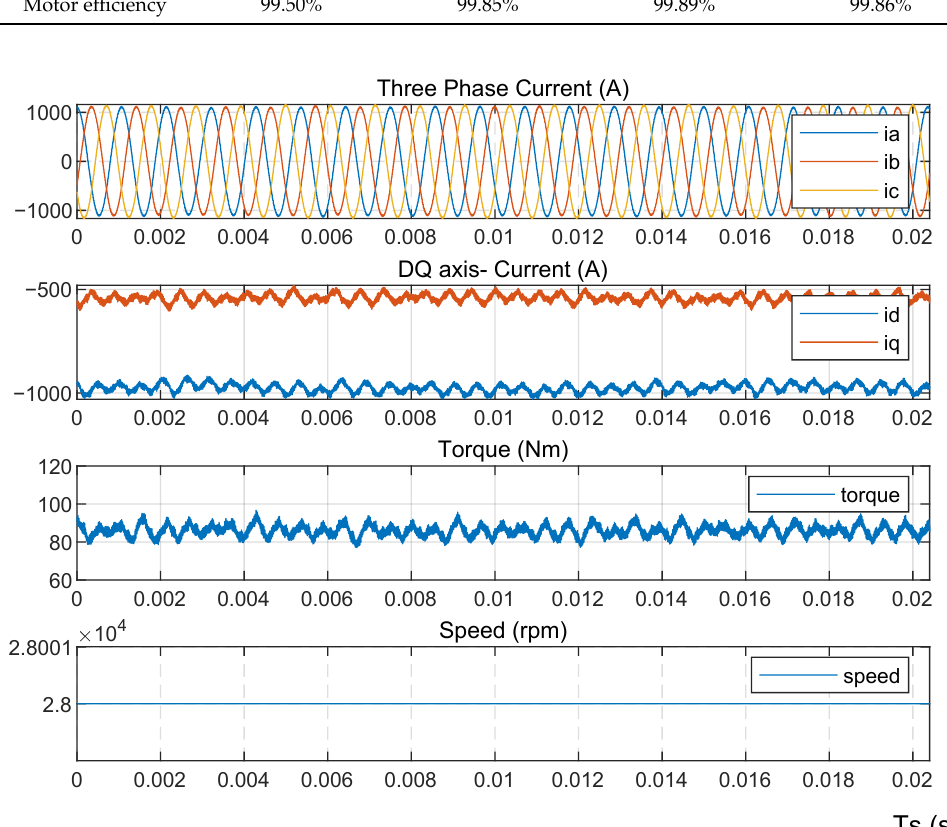
Figure 6. Experimental results of Model